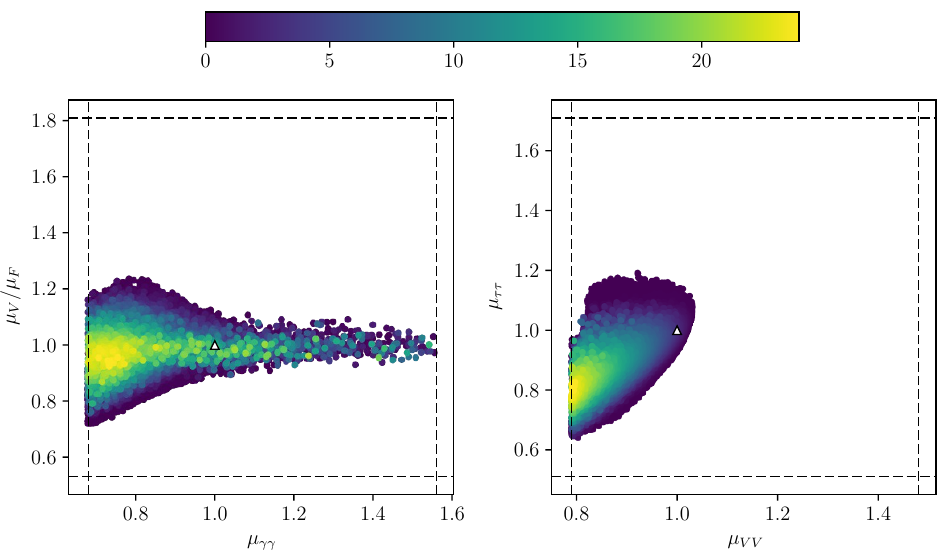
Figure 4 . C2HDM type I: pseudoscalar admixture (cid:9) C2HDM of h 125 as a function of the most constraining signal strengths. The dashed lines show the experimental limits and the white triangle denotes the SM